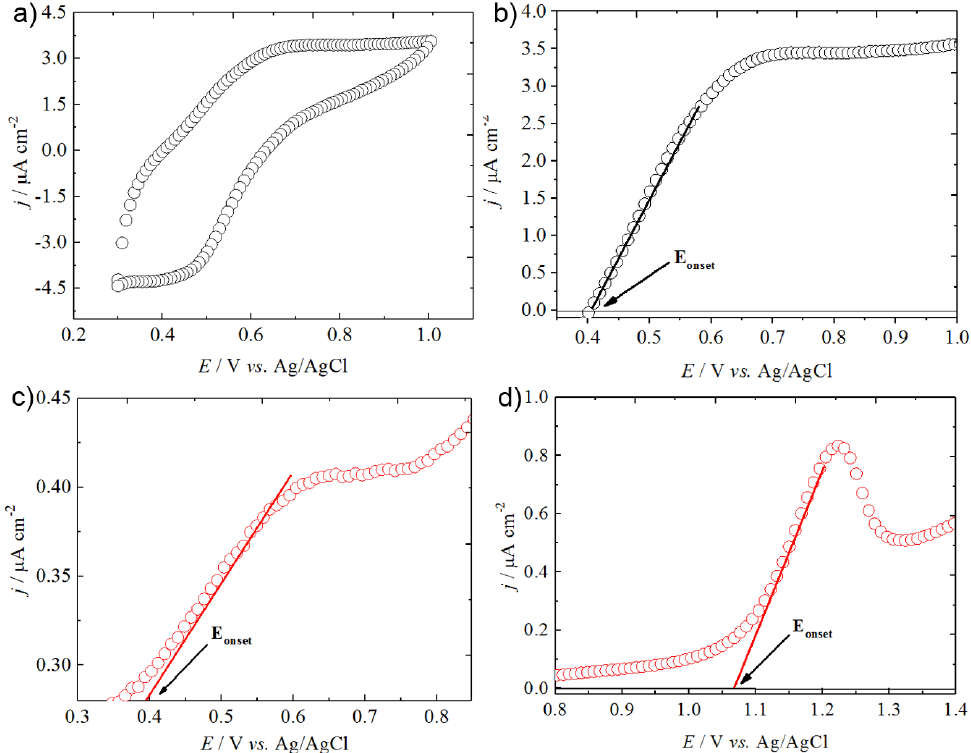
oxidation onset SO 0.1 mol l -1 . T 2 4 with AuNPs and d) 2